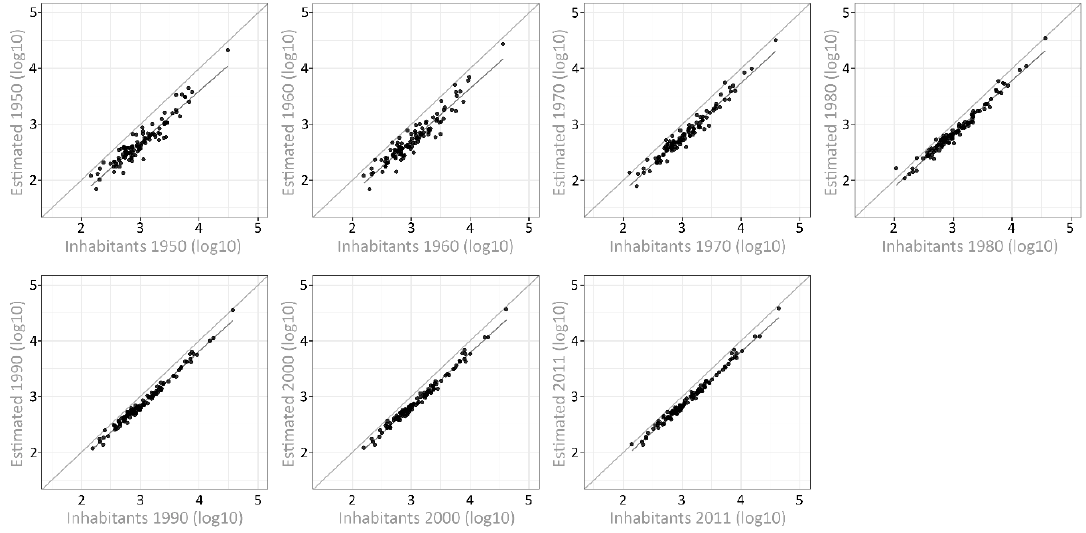
Figure 10. Scatter plot showing the estimated and reference values of the number of inhabitants. The light grey line represents the optimal result.